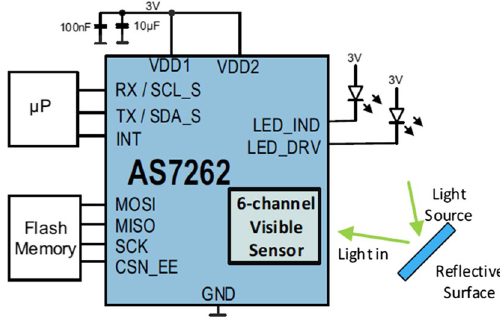
Fig. 3 Schematic of selected spectral sensor for handheld heavy metal